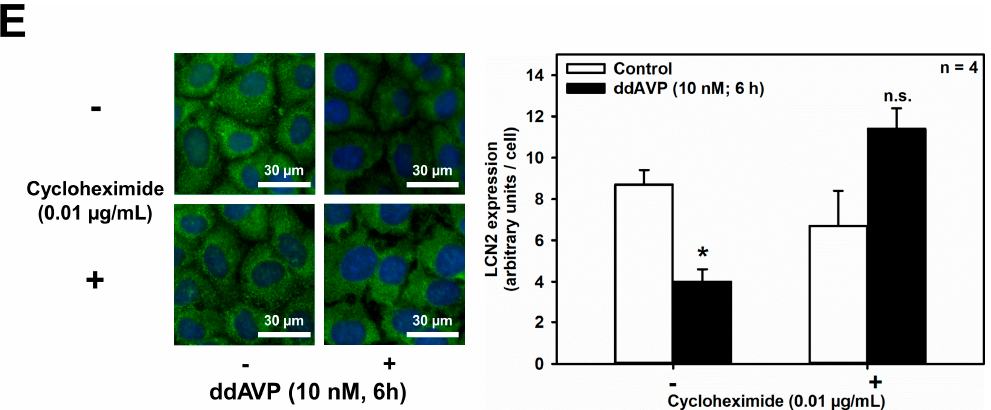
Figure 6. ddAVP decreases Lcn2 / LCN2 expression through a CREB-independent, posttranslational mode of action in mCCD(cl.1) cells. ( A , B ) Expression levels of Aqp2 ( A ) and Lcn2 ( B ) mRNA by RT-PCR in mCCD(cl.1) cells treated with ddAVP ± LPS. Data are means ± SEM of 5–6 experiments. Statistical analysis compares the expression levels of Aqp2 or Lcn2 in controls and ddAVP-treated cells ± LPS, by one-way ANOVA. n.s. = not significant. ( C ) Expression levels of Lcn2 mRNA by qPCR in mCCD(cl.1) cells treated with ddAVP ± 666-15. Data are means ± SEM of nine experiments. Statistical analysis compares relative expression levels of Lcn2 in controls and ddAVP-treated cells ± 666-15, by one-way ANOVA. n.s. = not significant. ( D ) Expression and secretion of LCN2 in mCCD(cl.1) cells treated with LPS, in the absence or presence of ddAVP. Media (supernatant), treated as described in Figure 5E, were immunoblotted. Cellular LCN2 protein expression was normalized to β -actin. Data are means ±